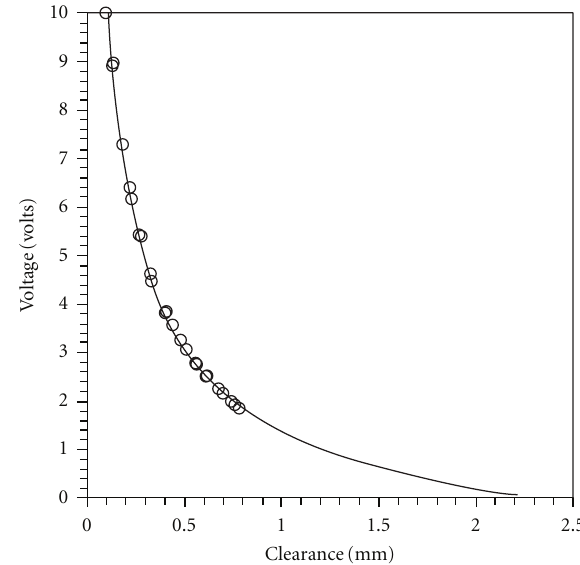
Figure 16: FM capacitance probe calibration obtained without datuming the probe or knowing the length of each blade relative to the longest blade. The figure also shows the actual position of the data points used in the calibration.